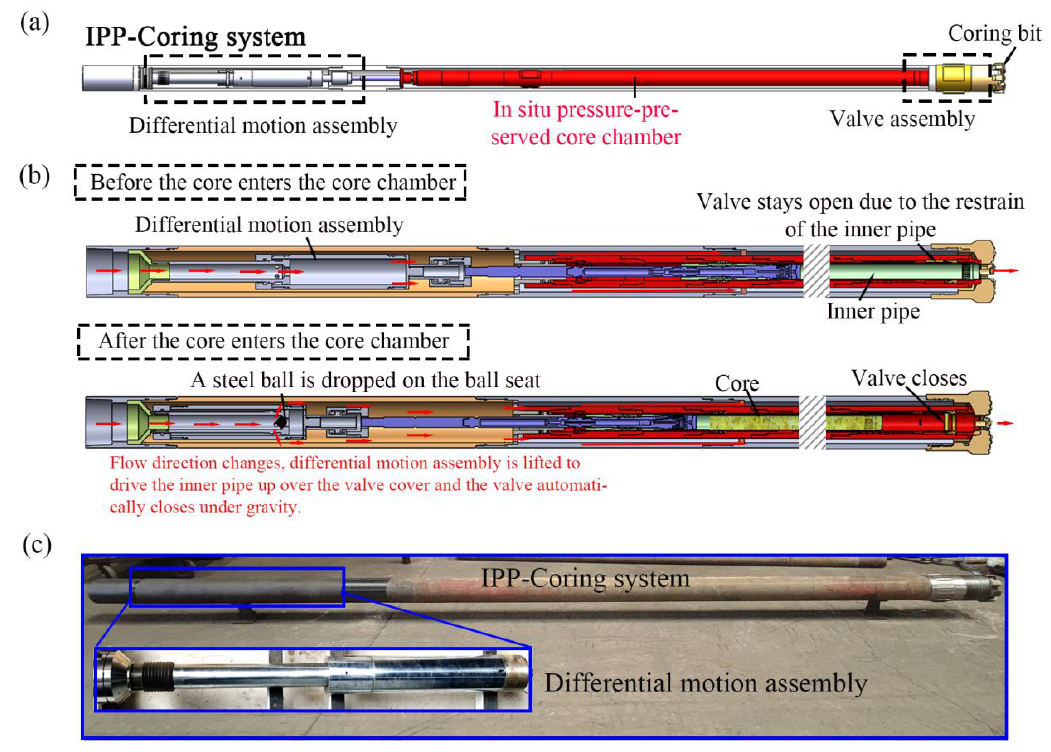
Figure 1. ( a ) Schematic diagram of the IPP-Coring system. ( b ) Schematic diagram of the working principle of the IPP-Coring system and the differential motion assembly. ( c ) Photographs of the IPP-Coring system and the differential motion assembly.